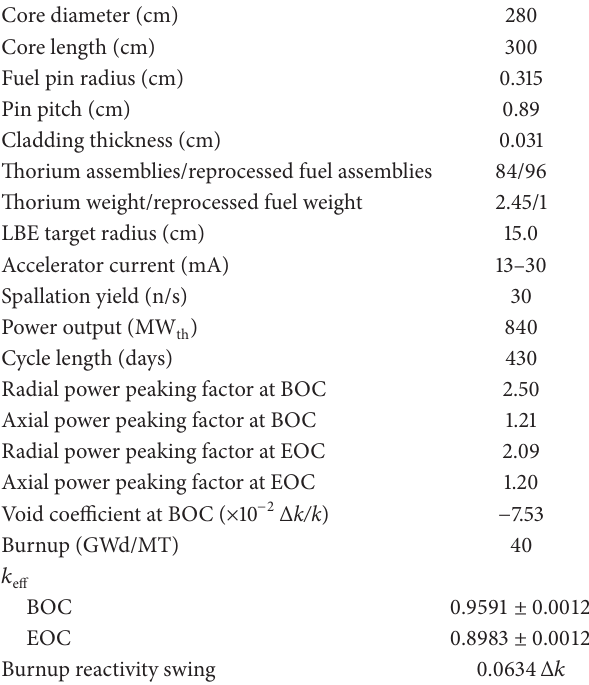
Table 2: Performance characteristics of the ADS.